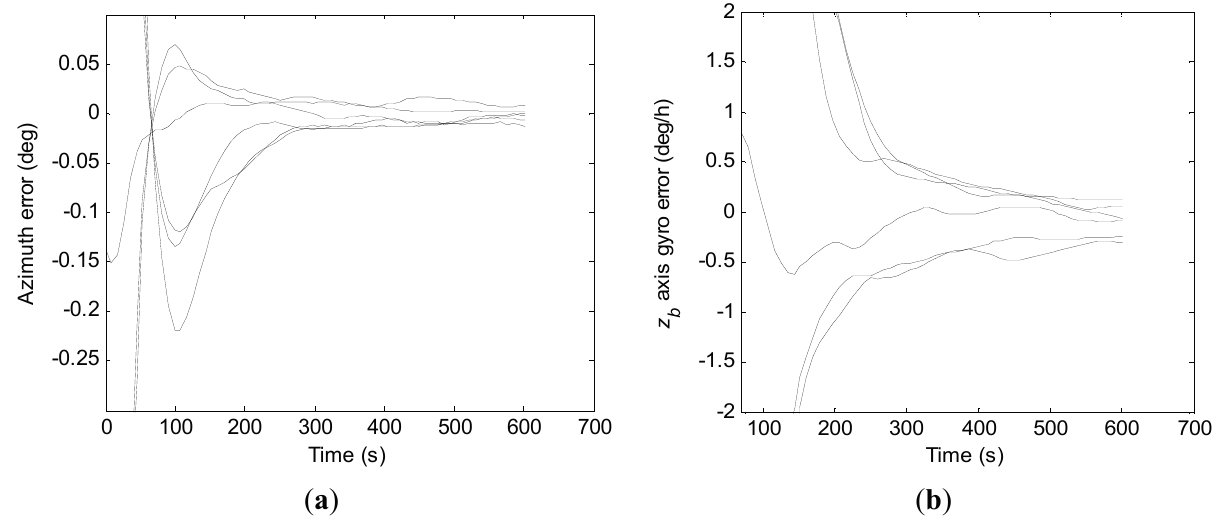
Figure 12. Convergence curves of the azimuth error and the z b axis gyro error within 600 s by the conventional KF scheme. ( a ) Azimuth error; ( b ) z b axis gyro erro. Convergence curves of the azimuth error and the z b axis gyro error within 600 s north-finding time obtained with the constrained KF scheme are shown in Figure 13, respectively.